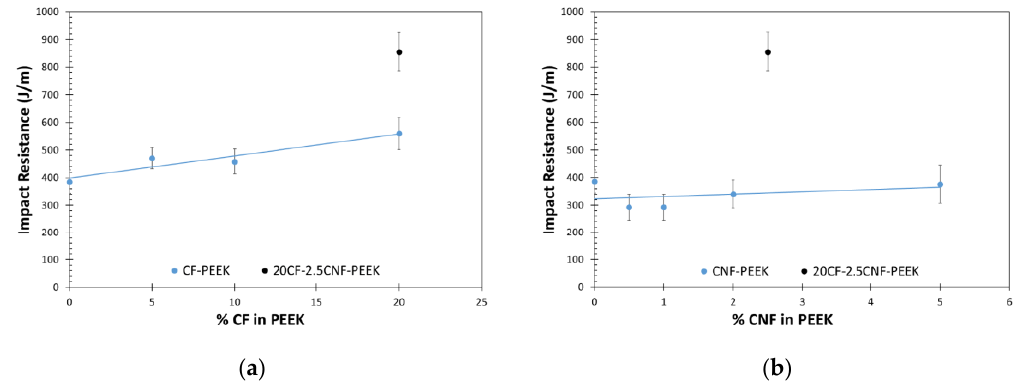
Figure 8. Notched Izod impact resistance comparison for 20CF–2.5CNF-PEEK and ( a ) CF-PEEK and ( b )